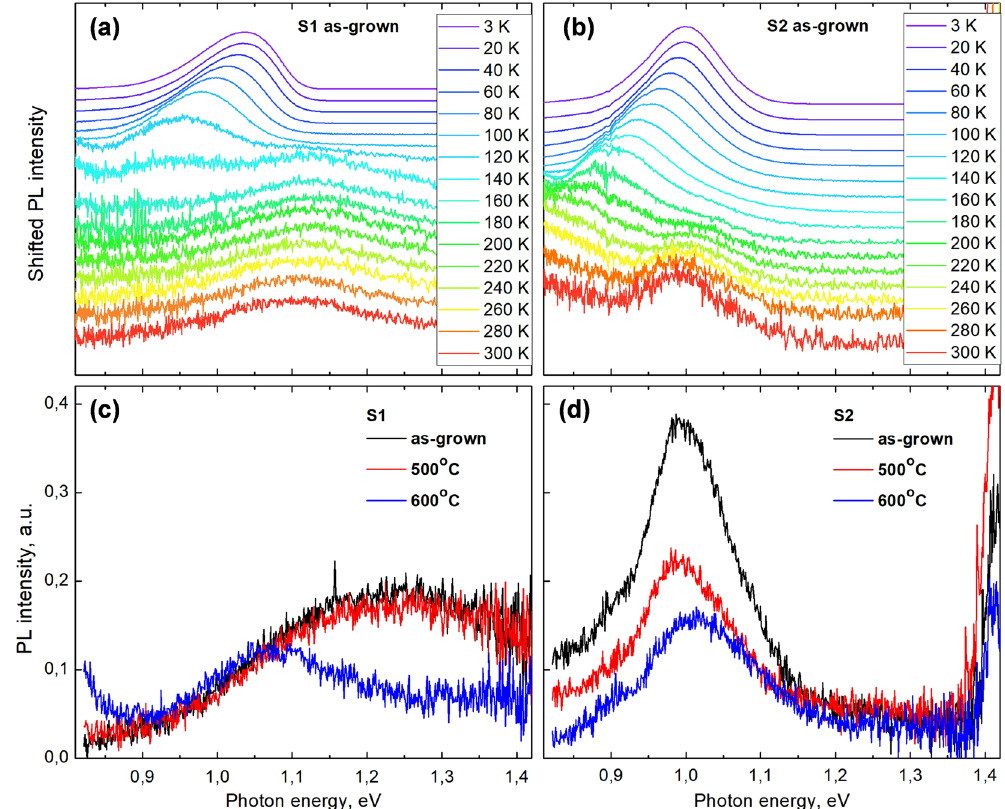
Figure 7. ( a , b ) Temperature-dependent photoluminescence of as-grown samples S1 and S2 in the temperature range 3–300 K. The spectra are normalized to the maximum of GaAsBi PL emission at each temperature and shifted vertically for clarity. ( c , d ) Room-temperature PL of the as-grown and annealed samples S1 and